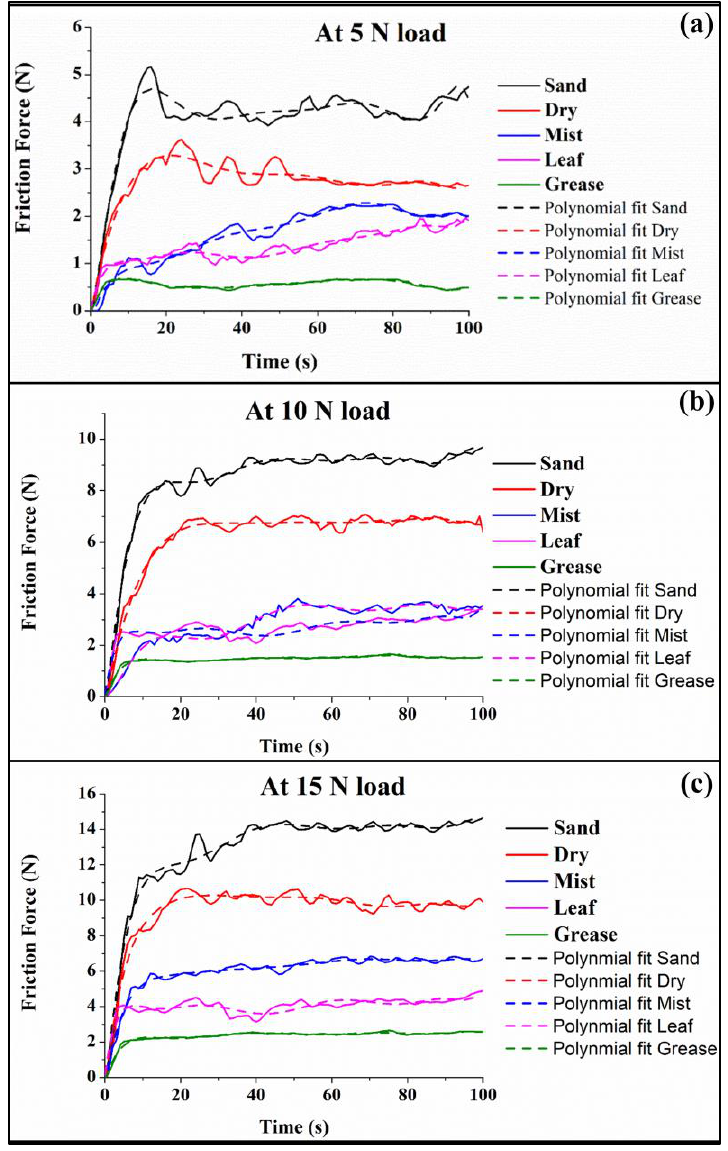
Figure 5. Variation of friction force versus time for normal loads ( a ) 5 N ( b ) 10 N ( c ) 15